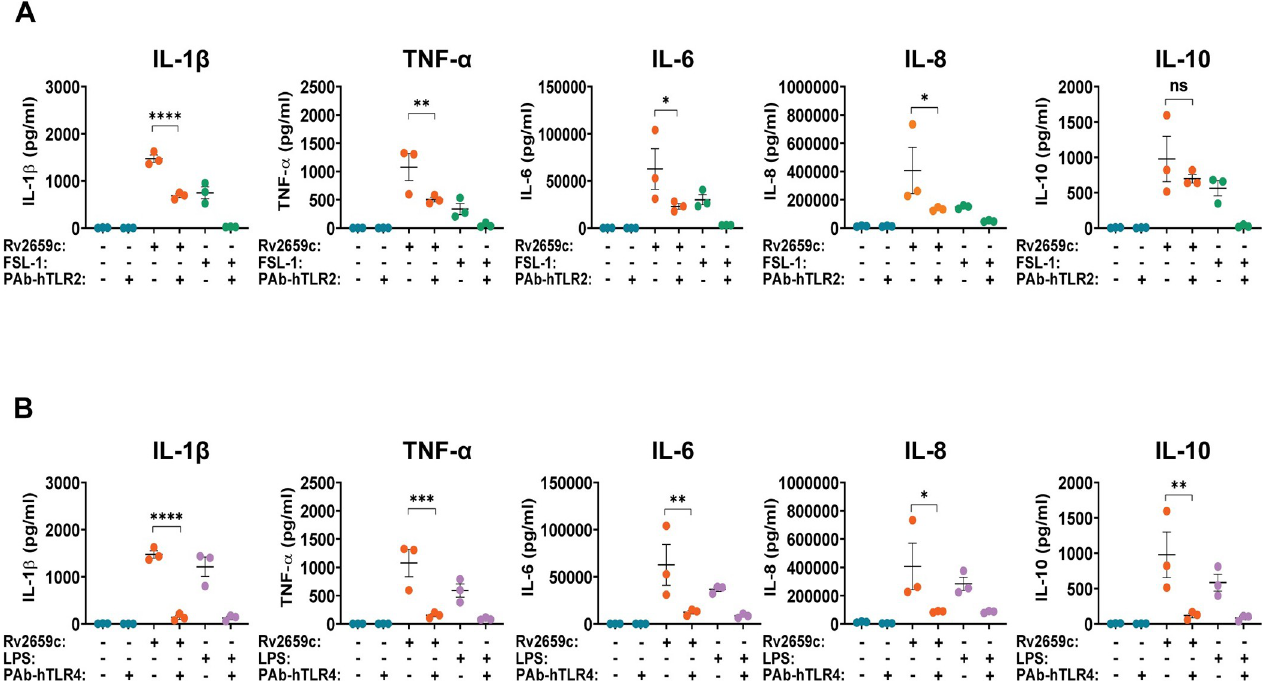
Fig 4. Recombinant protein Rv2659c induced the production of pro- and anti-inflammatory cytokines in hPBMCs through hTLR2 and hTLR4 interactions. (A) Cytokine production from hTLR2 blocking group. (B) Cytokine production from hTLR4 blocking group. The ligand-binding pockets of hTLR2 and hTLR4 in human PBMCs were blocked with 5 μ g/ml of anti-hTLR2 and anti-hTLR4 antibodies, respectively, for 1 hour. Protein Rv2659c (6.4 μ g/ ml) was then added and incubated for the next 24 hours. For the blockings of untreated cells, FSL-1 (100 ng/ml) and LPS (1 μ g/ml) served as systemic controls. IL-1 β , IL-6, IL-8, IL-10 and TNF- α in the culture supernatants were quantitated by CBA assay. Data were evaluated by flow cytometry, analyzed by FCAP array software and represented as mean ± SEM of 3 individual subjects (each was done in duplicate). One-way ANOVA with Sidak’s post hoc test was used for statistical analysis. p values are represented with asterisk symbols ( � p < 0.05 �� p < 0.01, ��� p < 0.001 and ���� p < 0.0001).